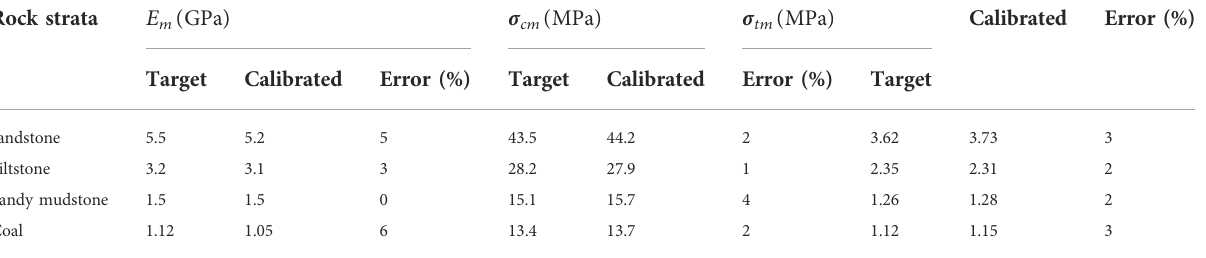
TABLE 3 Target values and fi nal simulation results for rock mass for UDEC-Trigon